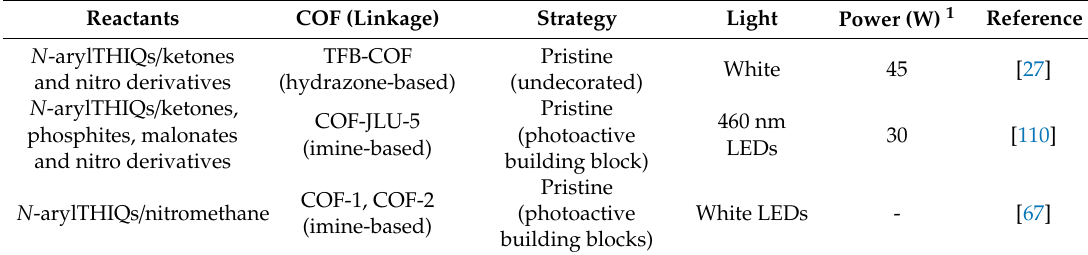
Table 13. Photocatalytic CDC reaction mediated by